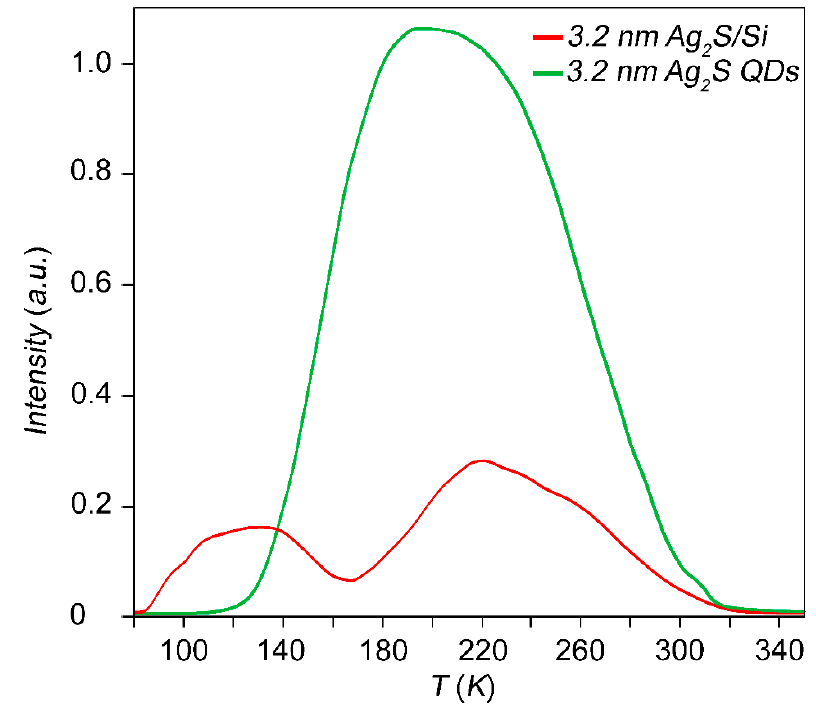
Figure 6. Curves of thermoluminescence for Ag 2 S QDs colloidal solutions (top curve) and Ag 2 S QDs deposed on Si substrate (bottom curve) with average size of 3.2 nm.